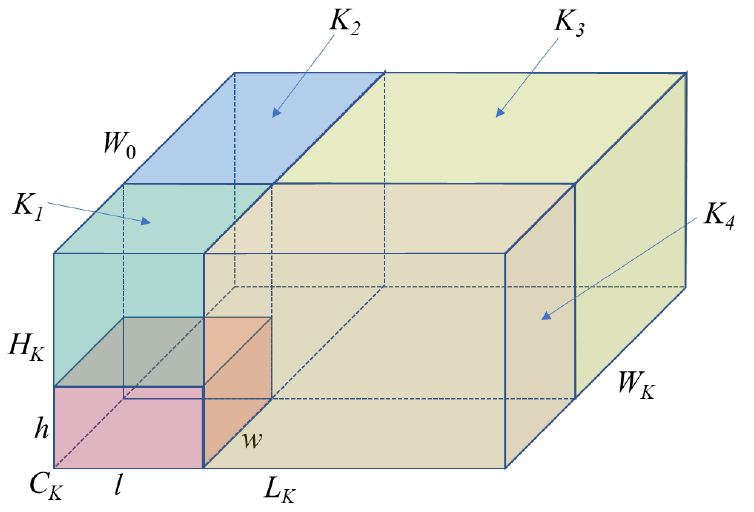
Figure 5. Splitting the space K .